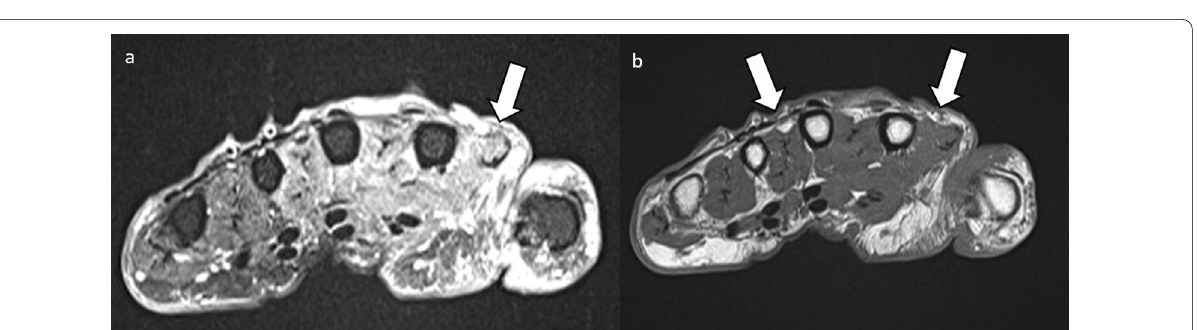
Fig. 16 Axial PD ( a ) and PDFS ( b ) palm of an 80-year-old female. There is increased oedema and volume loss in the intrinsic muscles of the hand radially (white arrows). This is consistent with deep ulnar nerve denervation pattern